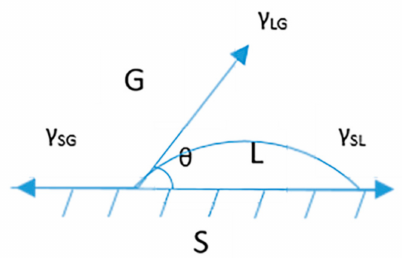
Figure 7. Contact angle diagram, showing the gas (G), liquid (L) and solid (S) regions, with